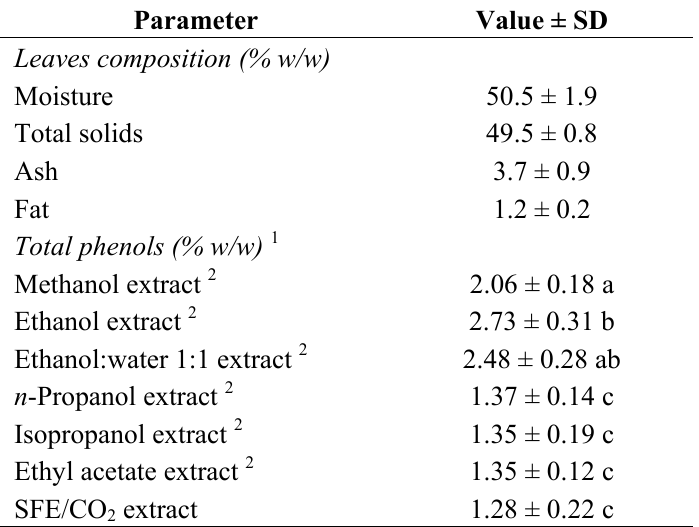
Table 1. Olive leaves characterization and total phenol